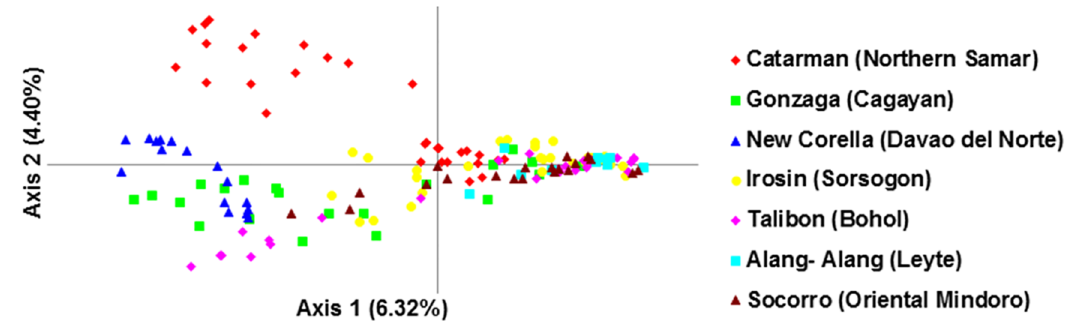
Fig 2. A two-dimensional plot of the Principal Coordinate Analysis (PCoA) of microsatellite data showing the clustering of Schistosoma japonicum populations after removal of duplicate genotypes. The proportionof variation is explainedby each axis in parenthesis.